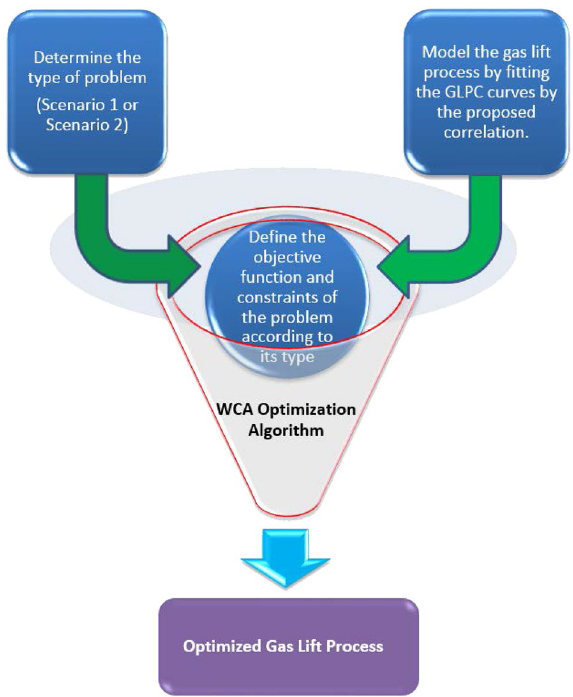
Fig. 3 Graphical demonstration of the procedure used in this study to solve the gas lift optimization